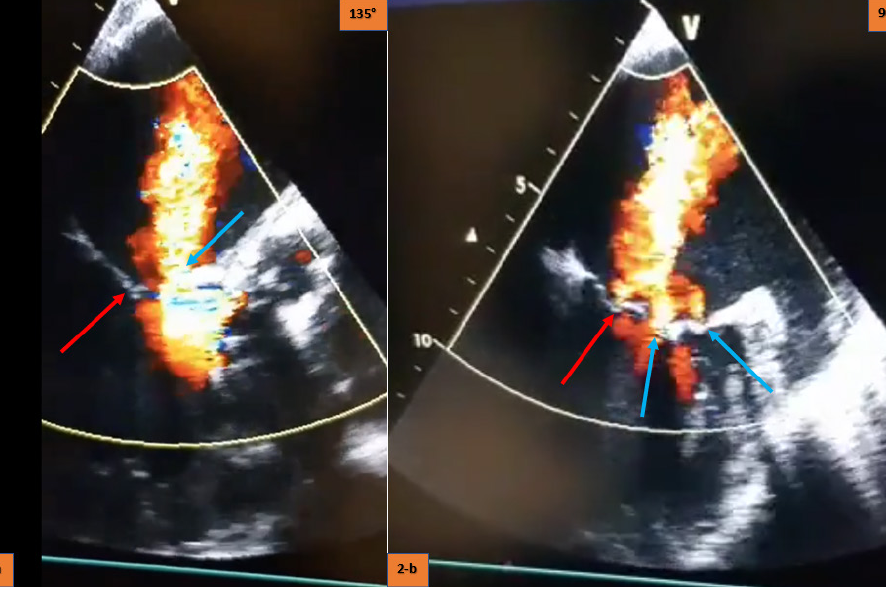
Fig. 2 – (A) Red arrow shows native mitral valve coaptation line; blue arrow shows anterior mitral valve perforation hole. (B) Red arrow shows native mitral valve coaptation line with mild degree regurgitation; blue arrows show two different holes from anterior mitral valve perforation.